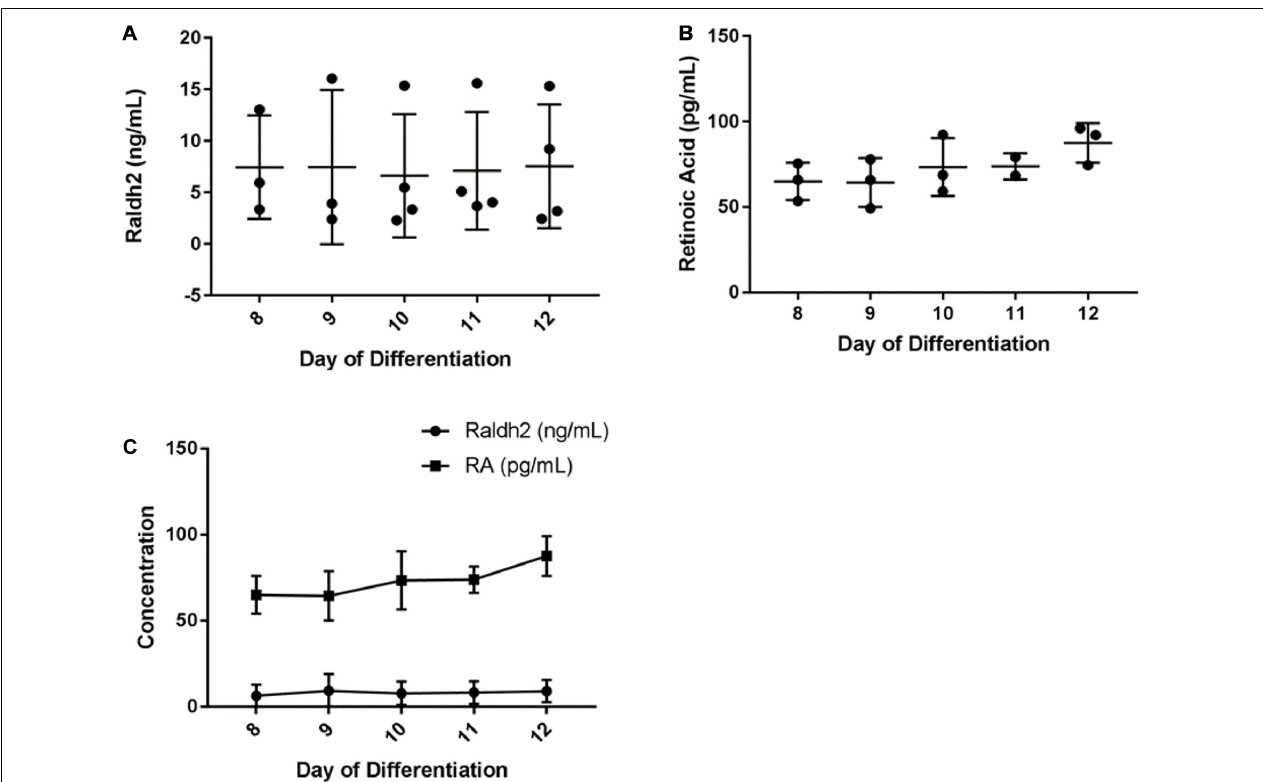
FIGURE 8 | ELISA determination of HGF11-derived MN expression of (A) Raldh2 (B) RA, and (C) comparison of the 2 over 8–12 day period. Error bars: mean and SD. n = 4 independent experiments, 3 technical replicates per